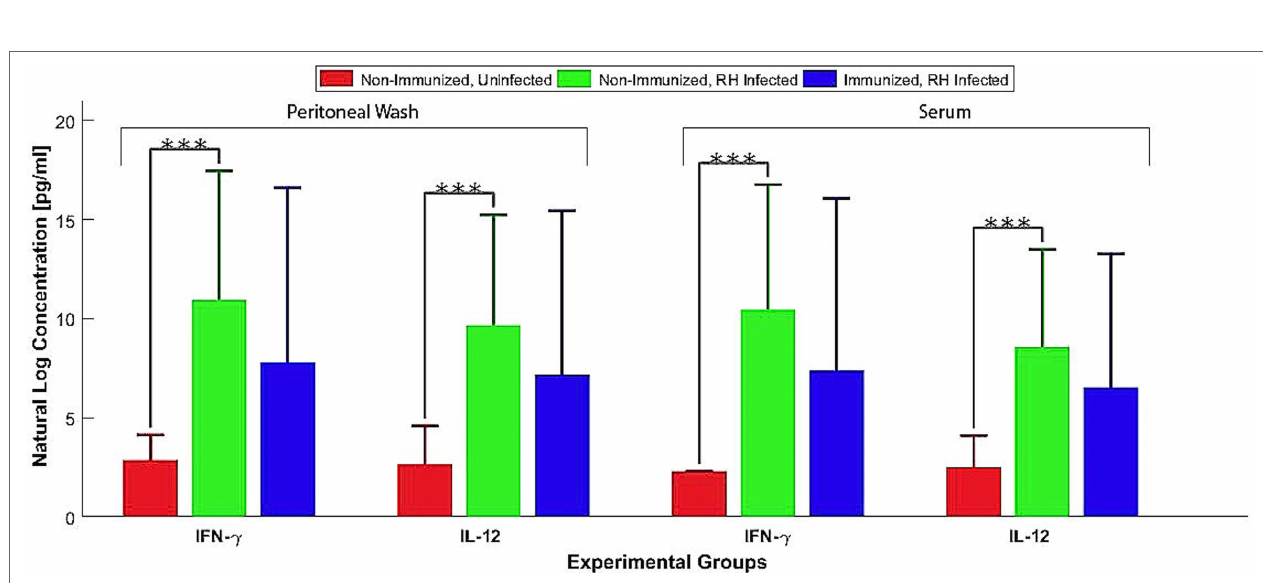
FigUre 7 | Pro-inflammatory cytokines produced by Δ GRA17- immunized mice after challenge with Toxoplasma gondii RH. Mice were challenged with 1 × 10 3 RH tachyzoites 70 days postimmunization and the levels of IFN- γ and IL-12 in the serum and peritoneal washes were assessed by ELISA at 7 days postinfection. Highest levels of pro-inflammatory cytokines were found in the non-immunized and infected mice. Significance compared with naïve control mice: *** p < 0.001.